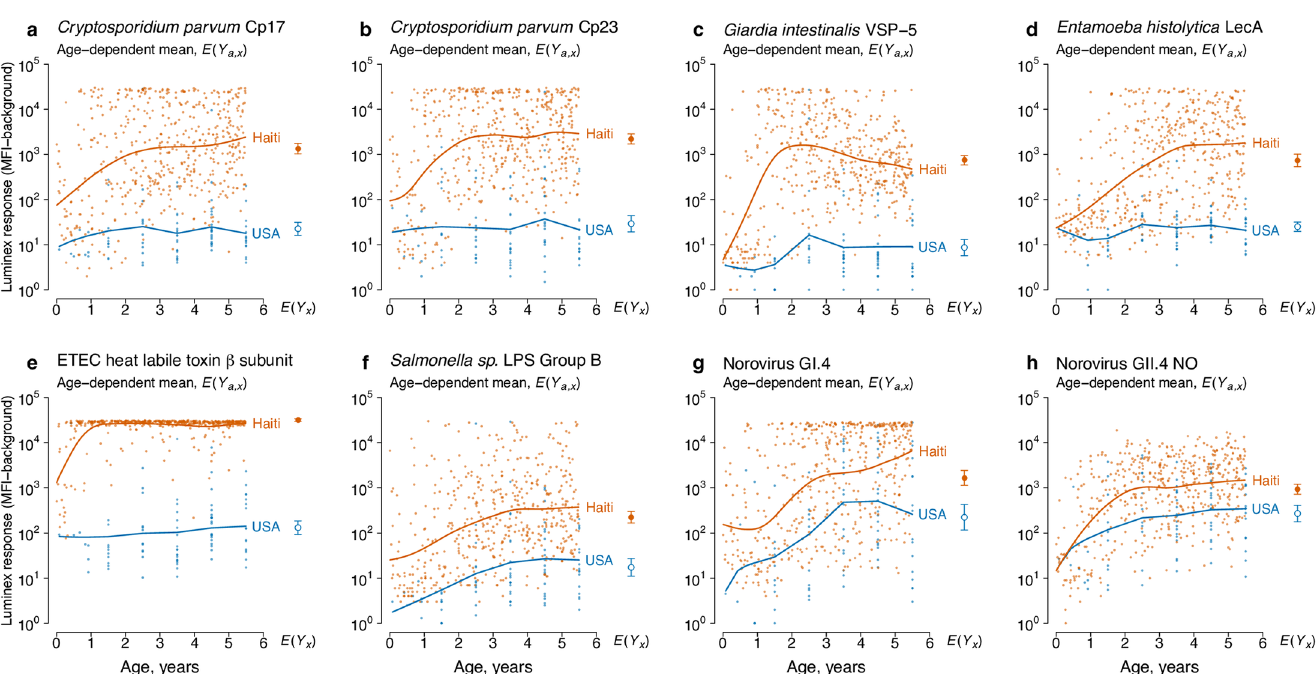
Fig 5. Differences in enteric pathogen transmission between children in Leogane, Haiti (N = 511) and the United States (USA) (N = 86) measured by age-antibody curves. Antibody responsemeasuredas medianfluorescence intensity (MFI) minus background in multiplexbead assays on the Luminexplatform. In each panel, individualantibodyresponses (points) are shown along with age-dependent means. Each panel also includesthe geometric mean by country, E ( Y x ), with error bars marking95% confidenceintervals(all differences significantat P (cid:20) 0.001 after Bonferroni correction). a. Cryptosporidiumparvum recombinant 17-kDa antigen; b. Cryptosporidiumparvum recombinant 27-kDa antigen; c. Giardiaintestinalis variant-specific surface protein-5(VSP-5); d. Entamoeba histolytica lectin adhesion molecule(LecA); e. enterotoxigenic Escherichia coli (ETEC) heat labiletoxin β subunit; f. Salmonella spp . lipopolysaccharide (LPS) Group B; g. NorovirusGroup I.4; h. NorovirusGroup II.4 New Orleans. The source data used to generate this figure are here: https://osf.io/8tqu4 (enterics), and the scripts used to generatethe figure are here: https://osf.io/ek3sx (enterics).